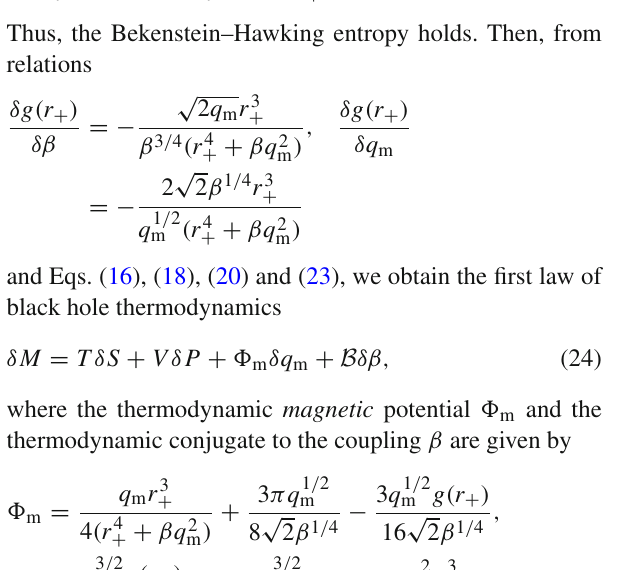
Fig. 2 The plot of the function (cid:12) m vs r + at q m = 1. The solid curve is for β = 0 . 05, the dashed curve corresponds to β = 0 . 1, and the dashed/dotted curve corresponds to β = 0 . 5